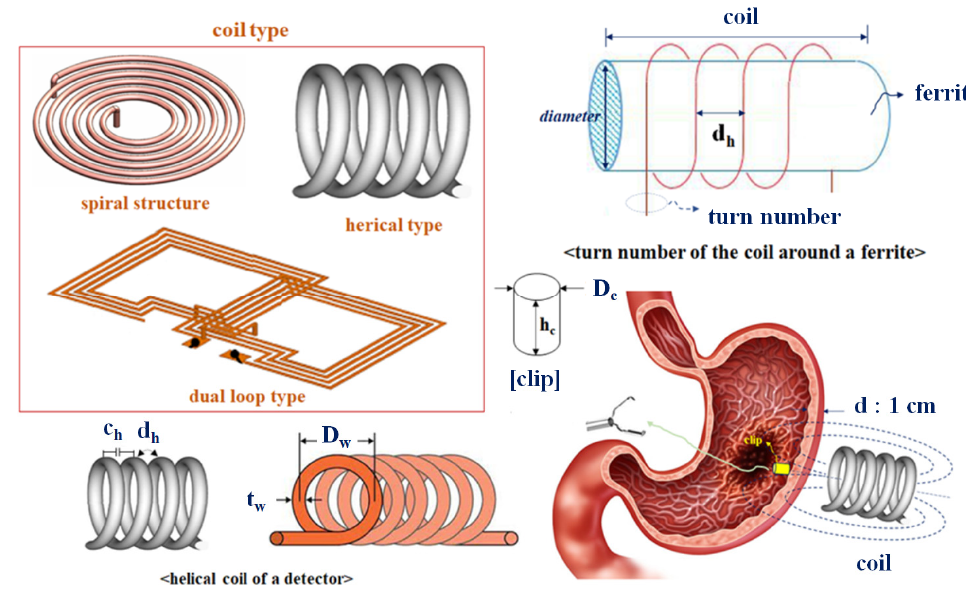
Figure 5. Number and structure of coil turns for clip